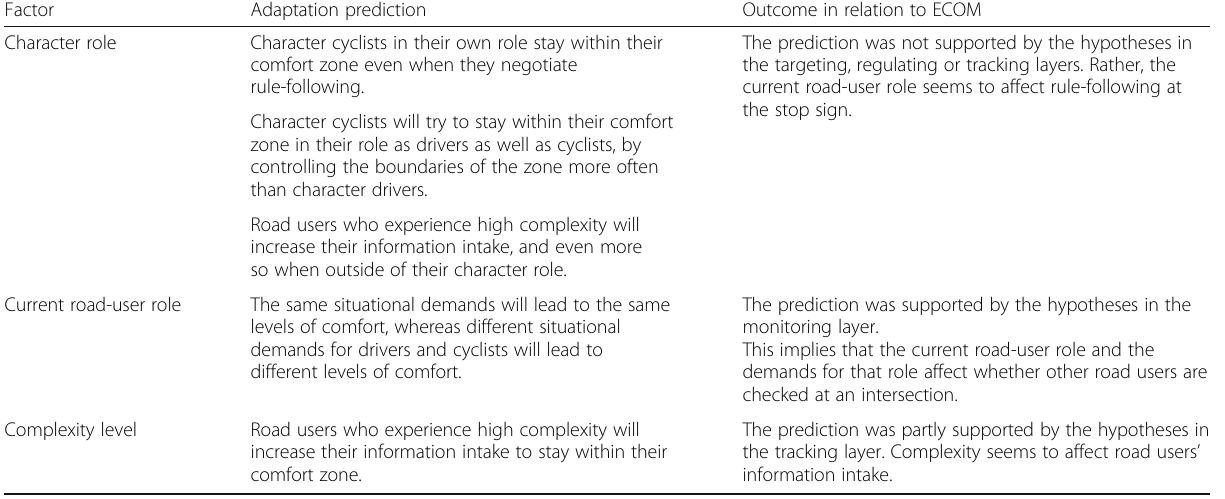
Table 5 Overview of outcome of the study in relation to ECOM and the adaptation predictions in Table 1 Factor Adaptation